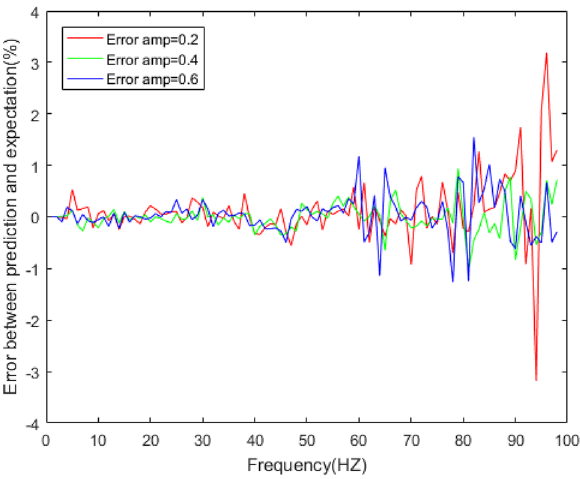
Figure 16. Errors between the prediction results and experimental results of the loss factor under different